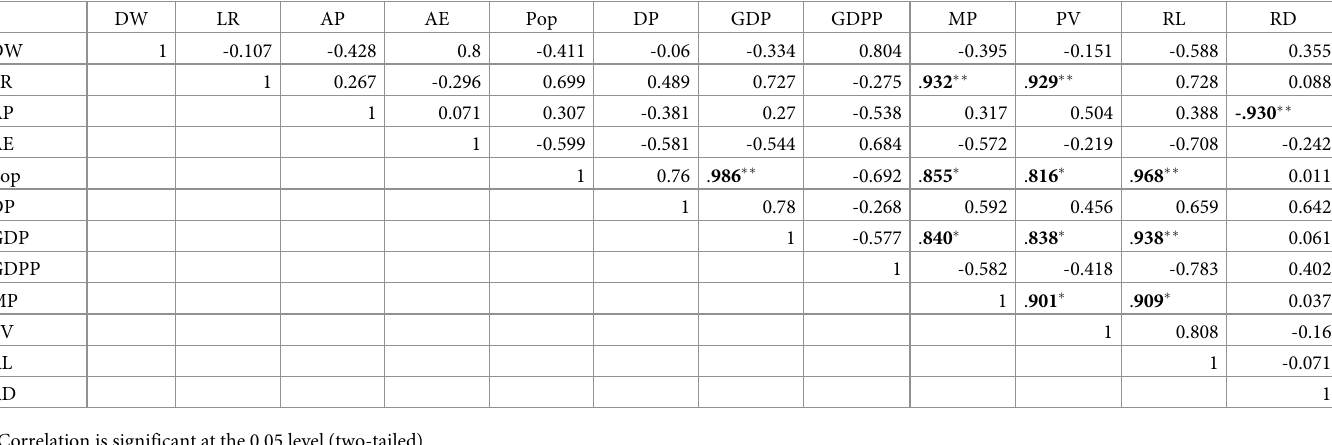
Table 5. Coefficient matrix of Correlation analysis between SGT